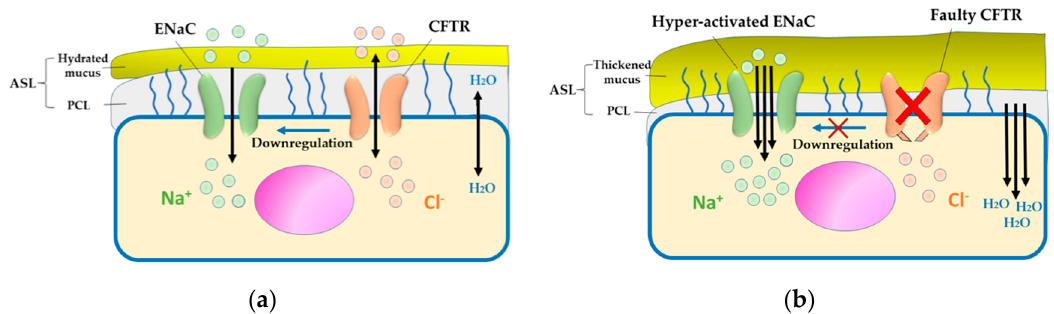
Figure 1. Pathogenesis of cystic fibrosis ( CF). ( a ) In normal epithelial cells, salt and water secretion is coordinated by cystic fibrosis transmembrane conductance regulator ( CFTR) and absorption via ENaC, which hydrates the airway surface liquid (ASL). ( b ) In CF airway epithelium, defective CFTR impairs Cl − ion and water exchange, causing epithelial sodium channels (ENaC) hyperactivation and leading to dehydrated ASL and thickened mucus, which is considered a conducive environment for infection and inflammation.